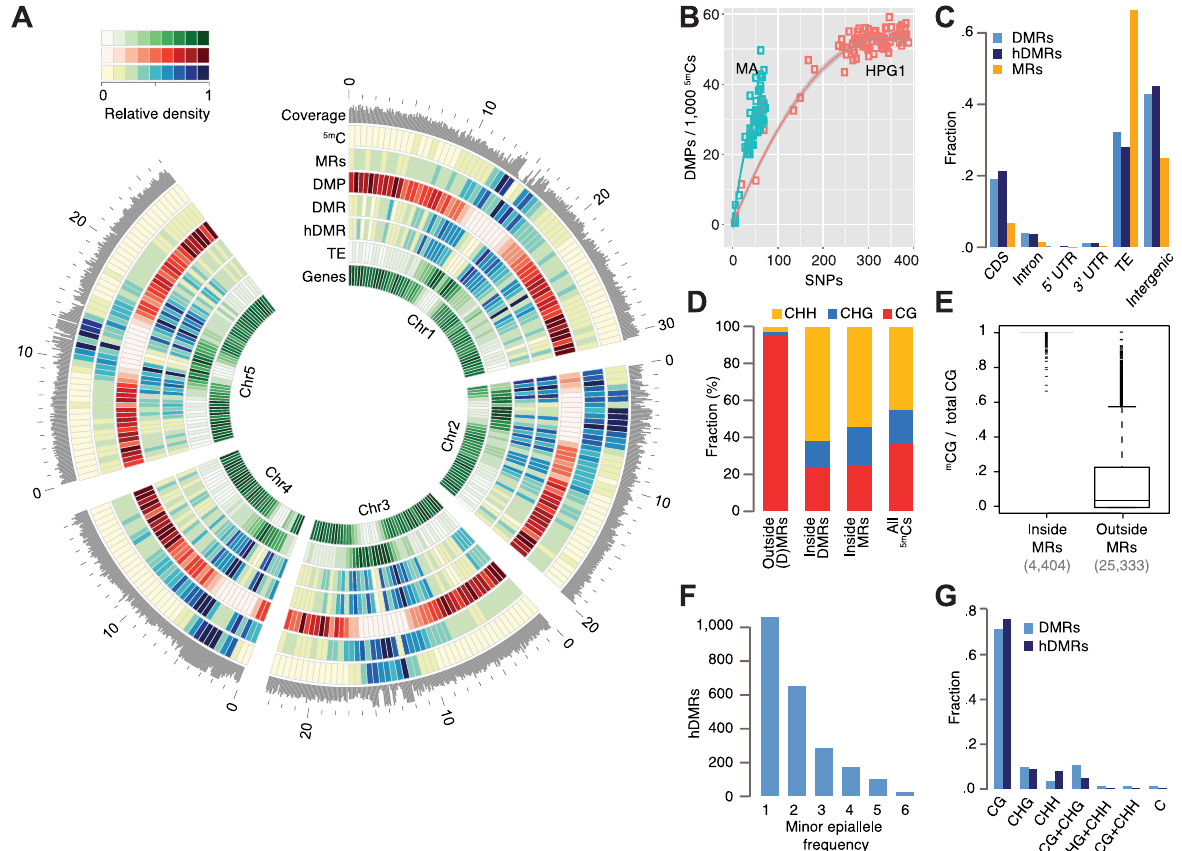
Fig. 2. Epigenetic variation in a nearly isogenic population. (A) Genome-wide features: average coverage in 100 kb windows, the remainder in 500 kb windows. Outside coordinates in Mb. (B) Number of DMPs in relation to number of SNPs in pairwise comparisons. Data of mutation accumulation (MA) lines are based on single individuals, haplogroup1 (HPG1) data on pools of 8–10 individuals; each data point represents an independent comparison of two lines. DMPs in each pairwise contrast were scaled to the number of methylated sites compared. (C) Annotation of cytosines in MRs and hDMRs. (hD)MR sequences were assigned to only one annotation in the following order: CDS . intron . UTR . transposon . intergenic. (D) Sequence context of methylated positions relative to MRs and DMRs. (E) Fraction of 5m CGs among all CG sites for each gene and transposable element, with at least 5 CGs. (F) Minor epiallele frequencies of 2,304 hDMRs that could be split into only two groups and for which at least four strains showed statistically significant differential methylation. Strains not tested statistically significant for a particular hDMR were not considered for this plot. (G) DMRs and hDMRs according to sequence contexts in which significant methylation differences were found. ‘C’ denotes (h)DMRs in all three contexts. Abbreviations: 5mC: methylated position, CDS: coding sequence, DMP: differentially methylated position, DMR: differentially methylated region, hDMR: highly differentially methylated region, HPG1: haplogroup-1 lines, MA: mutation accumulation lines, MRs: methylated regions, SNP: single nucleotide polymorphism, TE: transposable element, UTR: untranslated